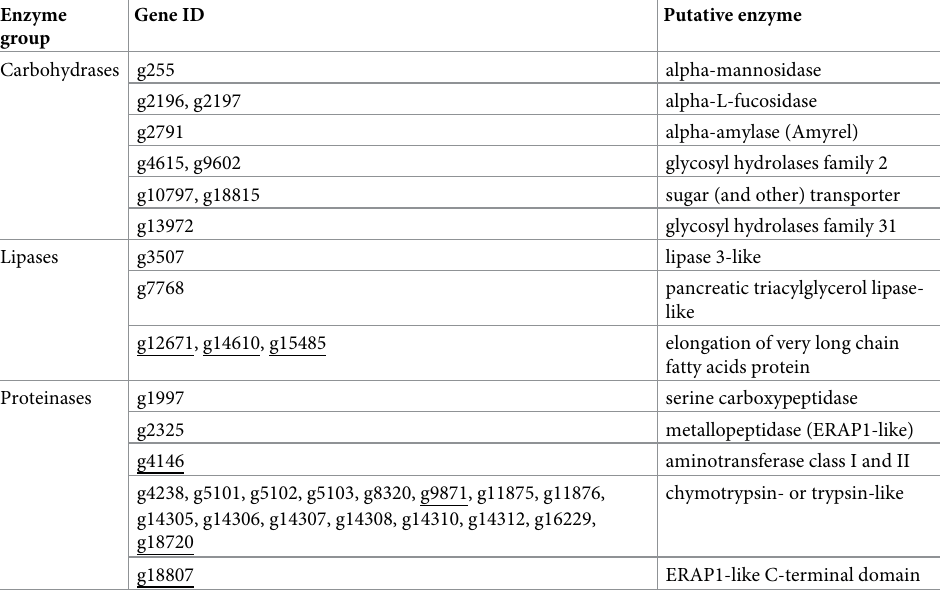
significant DEGs were searched against the eggNOG database, but we refrained from perform- ing further statistical comparisons on the functional categories. The top 100 identified up- and down-regulated DEGs were assigned to three eggNOG classifications, comprising information storage and processing, cellular processes and signaling, and metabolism (Table 8). Several gut-biased up- and down-regulated DEGs show a specific high expression, i . e . a higher mean of normalized read counts (NRC). Conspicuous high expression levels were found in four up-regulated genes in the adult wasps: g13972 and g16665 coding for the two carbohydrases glycosyl hydrolases family 31 and alpha-amylase, g18034 coding for the protein- ase serine 9-like, and g15485 encoding a lipase GNS1/SUR4 family. The genes g14306 and g14307, coding for typsin and chymotrypsin respectively, exhibit high means of NRC in the larvae (Fig 4). Moreover, the two down-regulated genes g12463 and g2792 found in adults wasps coding for the carbohydrases alpha-amylase and alpha-glucosidase respectively, exhibit a conspicuous high mean of NRC (Fig 4).